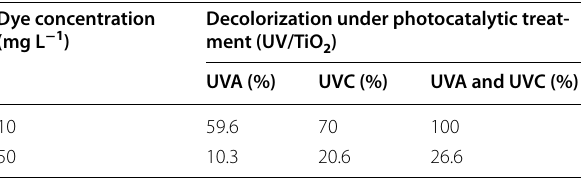
Table 3 Decolorization of Remazol black B under photo- catalytic treatment for 24 h (UV/TiO centrations